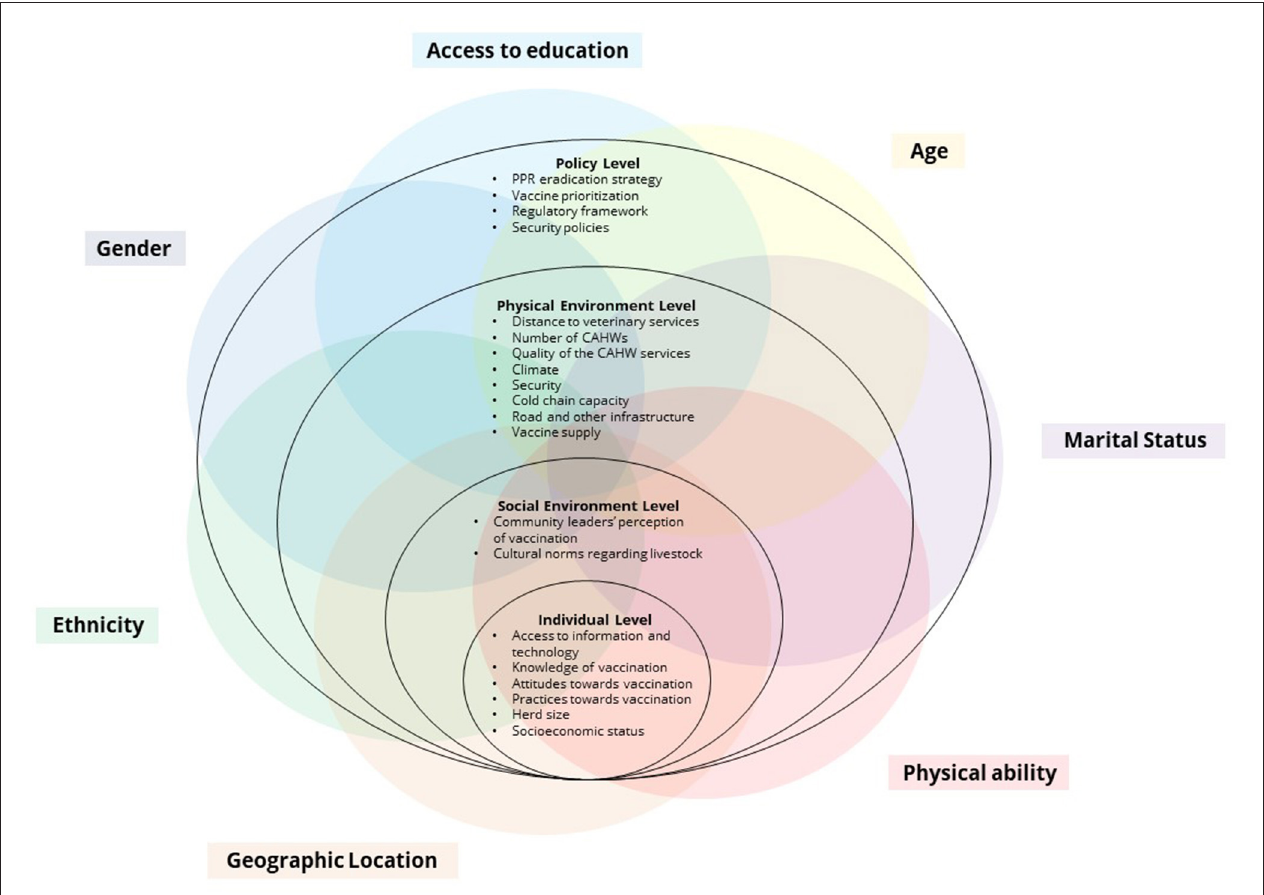
FIGURE 2 | SEM and Intersectionality frameworks for PPR vaccinations in Karamoja. The SEM was adapted from (37), and the combination of the SEM with the intersectional framework was adapted from (